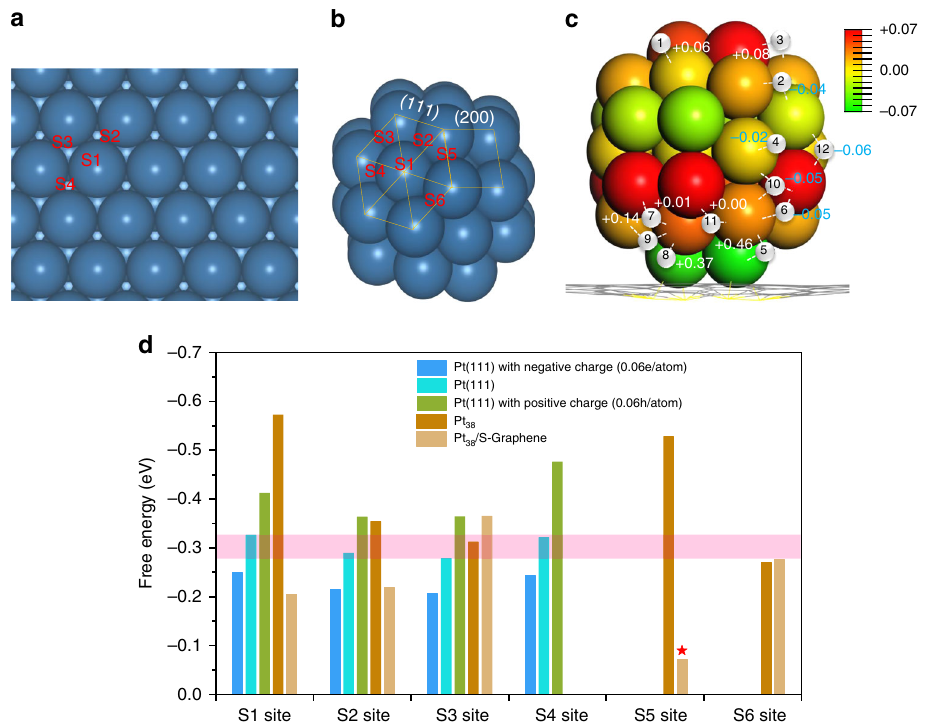
Fig. 6 Hydrogen atoms absorption sites and catalytic free energies. a , b Hydrogen atom absorption sites of Pt(111) a and Pt 38 cluster b . S1 – S4 denote the top site, bridge site, hcp site, and fcc site on crystal face (111), respectively. S5 denotes the bridge site at the edge of (111) and (200), and S6 is the bridge site at the edge of adjacent (111) face. c Difference bader charge analysis and difference Δ G energy analysis of Pt 38 /S-Graphene. The value of Δ e in Pt atom can be read from the color bar. The small white balls with number mark the absorption site with the corresponding δ G . d Calculated free energy diagram of Pt(111), Pt(111) with negative charge (0.06e/atom), Pt(111) with positive charge (0.06hole/atom), Pt 38 and Pt 38 /S-Graphene. The translucent pink belt denotes the cover range of Δ G of the